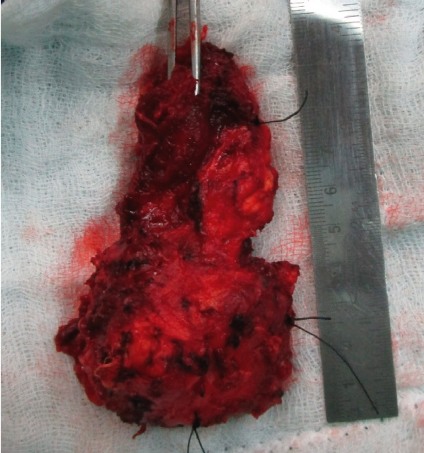
Figure 6: Excised